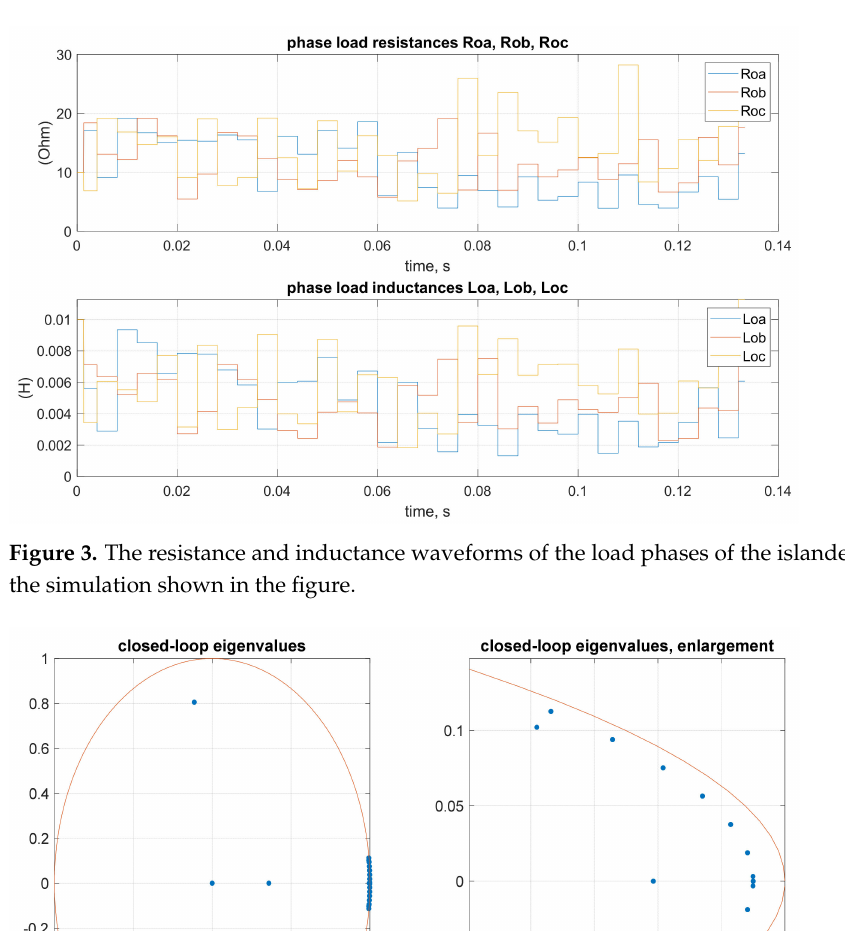
Figure 2. Waveforms of the islanded grid phase voltages V o and load current I o .